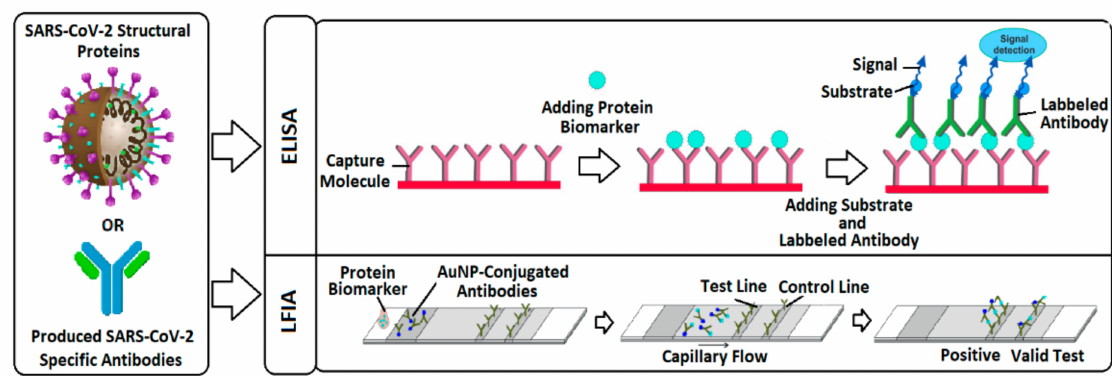
Figure 3. Schematic view of two main protein-based detection kits: ELISA employs capture molecules attached to the surface of the plates and detects the protein biomarker using specific labelled antibodies. Detection takes place by electronic plate reader, which is more accurate, or by the naked eyes. LFIA consists of a nitrocellulose strip which includes specific capture molecules in test line and control line and employs AuNPs for visual